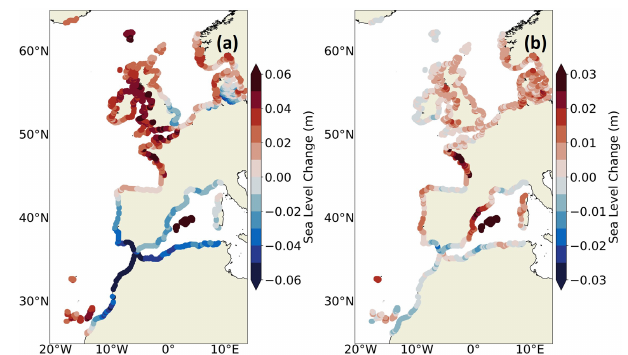
Figure 17. (a) Projected changes of the non-tidal residual 99th percentile for the SSP5-8.5 scenario between the 2081–2100 and 1986–2005 periods in IBI-CCS_corr. (b) Differences with projected changes in IBI-CCS_raw.